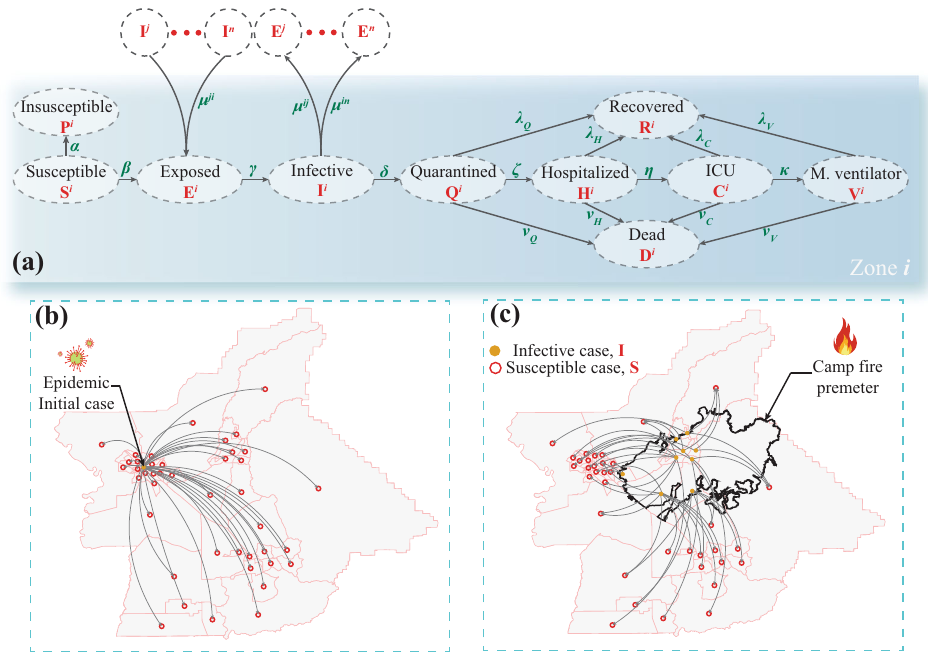
Fig. 5 Modi fi ed SEIR model. a The disease transmission model extending the classical SEIR model where the population in a census tract zone i is categorized into ten different cases while accounting for the possibility of disease spread ( b ) from infected to non-infected census tracts as well as c between the population from the evacuated zones, after the natural disaster, and their host